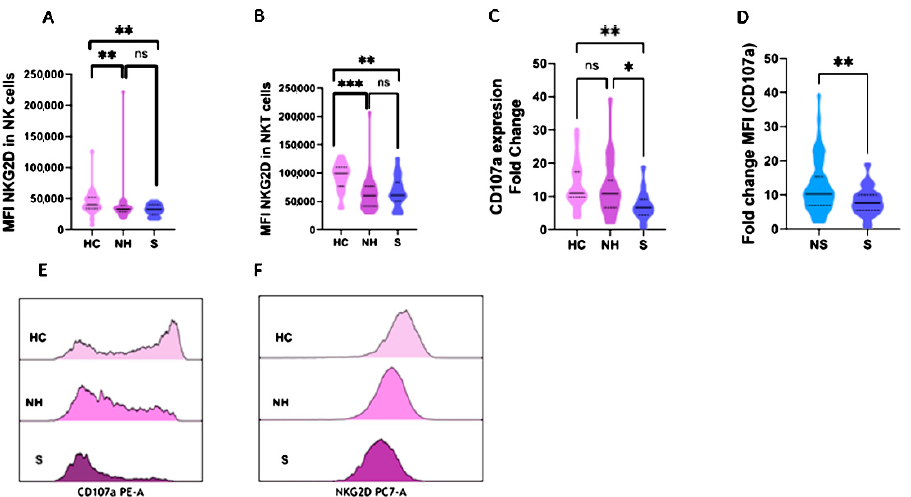
Figure 2. NK functionality in healthy controls (HC, n = 21), non-hospitalized (NH, n = 38), non-severe (NS, n = 75), and severe COVID-19 patients (S, n = 24). ( A ) MFI of NKG2D in NK cells; ( B ) MFI of NKG2D in NKT cells; ( C , D ) Fold Change (MFI CD107a); ( E ) CD107a MFI in NK cells, distribution for HC, NH, and S patients; ( F ) NKG2D MFI in NK cells, distribution for HC, NH, and S patients. HC, healthy controls; NH, Non-Hospitalized; NS, Non-severe; S, Severe; *, p < 0.05; **, p < 0.01; ***, p < 0.001.